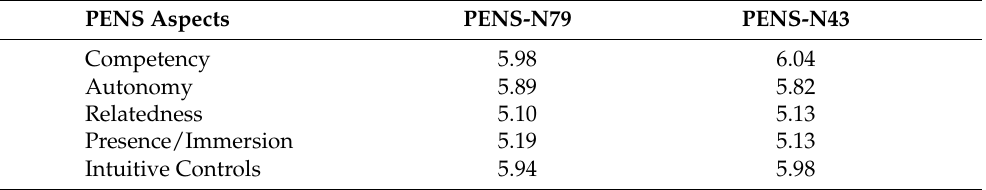
Table 8. The results of player experience of need satisfaction